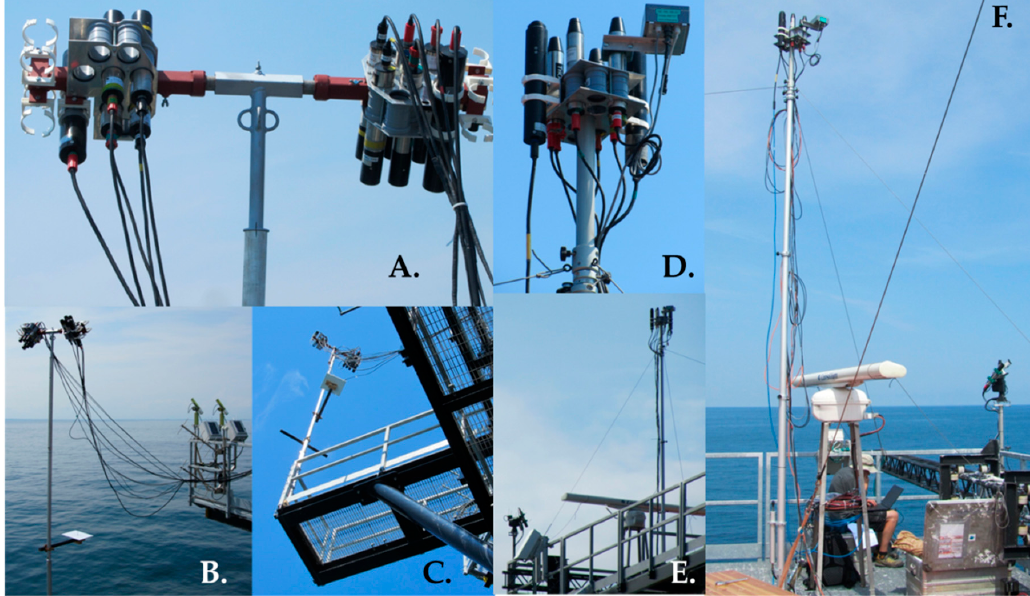
Figure 21. Configuration of sensors on the AAOT platform showing ( A ) the mounting for L sky and L t radiometers, ( B ) location of radiance sensors next to the AERONET-OC SeaPRISM, ( C ) location of the radiance sensors on level 3 of the AAOT, ( D ) location of the irradiance sensors on the mounting block, ( E ) telescopic mast with irradiance sensors at the eastern corner of the AAOT, ( F ) proximity of the telescopic mast with irradiance sensors and the PANTHYR system just above the railings below. Reproduced with permission from [54].